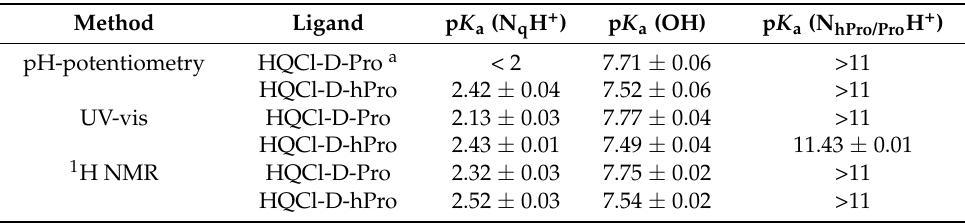
Table 2. Proton dissociation constants (p K a ) of the ligands. { I = 0.2 M KNO 3 ; T = 25.0 ◦